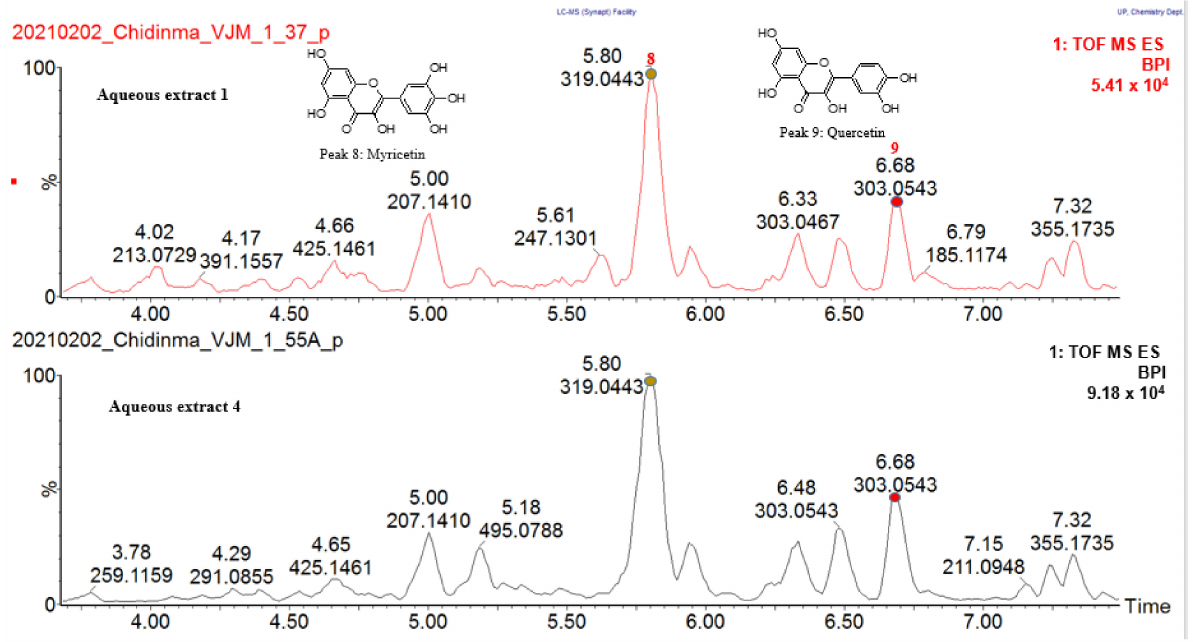
Figure 4. ESI positive mode BPI chromatogram of active S. birrea spray-dried aqueous leaf extracts (aqueous extracts 1 and 4) with expansion of region from 3.5 to 8.5 min. Two compounds were tentatively identified by comparing their accurate masses and MS/MS fragmentation pattern with compounds in databases such as Metlin, Metfusion, Chemspider, Pubchem, Dictionary of Natural Products and Waters UNIFY ® Scientific Information